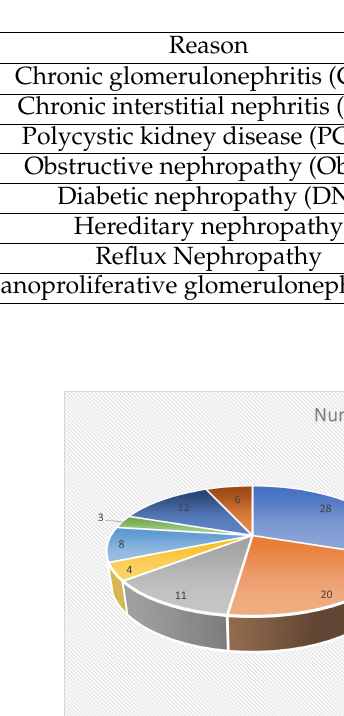
Table 1. Reason for end stage kidney disease.